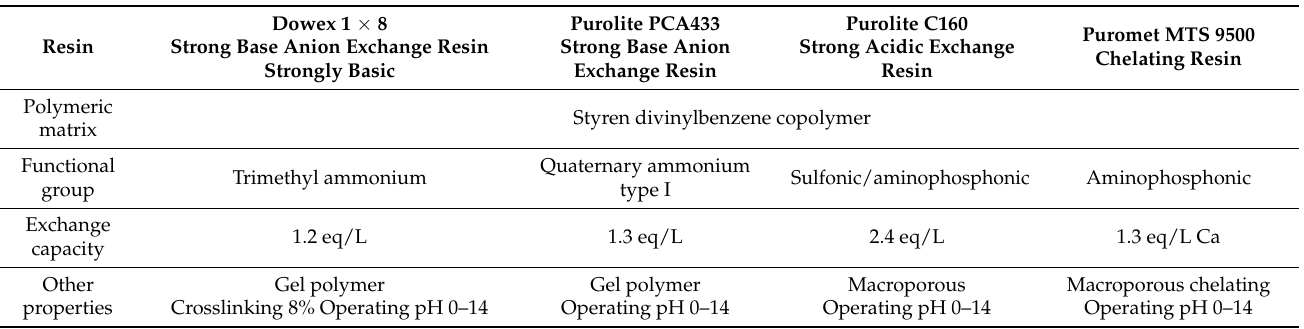
Table 3. Ion exchange resins used in the